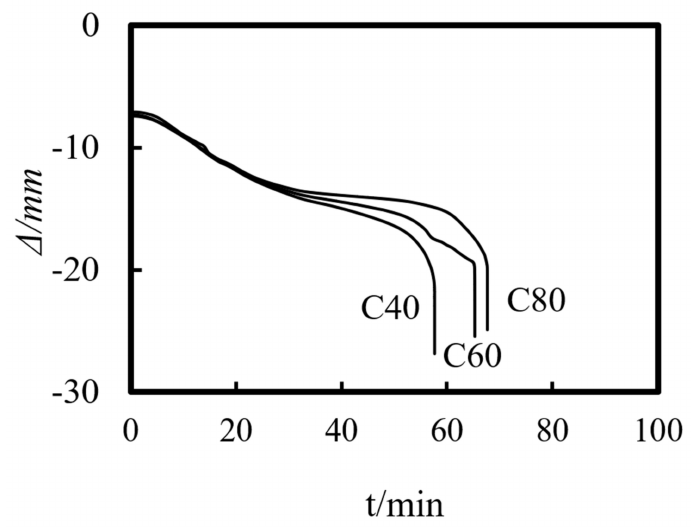
Figure 23. Effect of the external concrete strength on the axial deformation − time